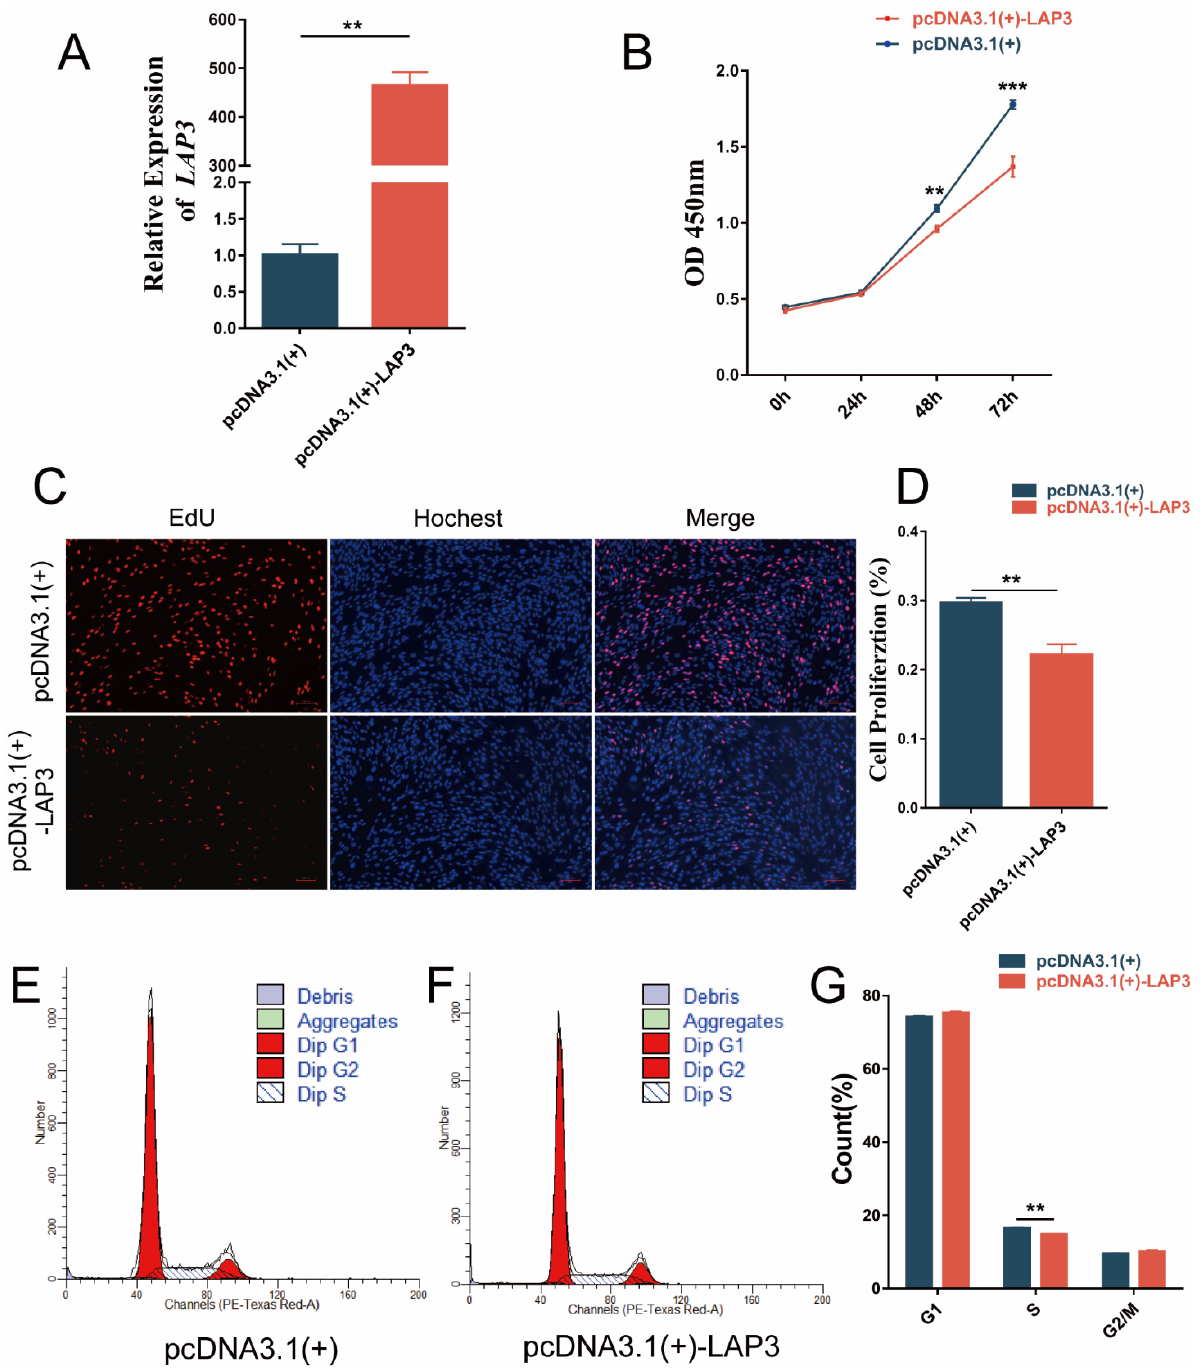
Figure 4. Effects of LAP3 overexpression on embryonic myoblasts proliferation. ( A ) Overexpression efficiency of LAP3 mRNA expression levels detected by RT-PCR in embryonic myoblasts. ( B ) CCK-8 assay of embryonic myoblasts transfected with pcDNA3.1(+)-LAP3 or pcDNA3.1(+) at 0 h, 24 h, 48 h, and 72 h. ( C ) EdU cell proliferation assay of embryonic myoblasts transfected with pcDNA3.1(+)-LAP3 or pcDNA3.1(+) (100×). ( D ) Cell proliferation rate of embryonic myoblasts transfected with pcDNA3.1(+)-LAP3 or pcDNA3.1(+). ( E , F ) Flow cytometric measurement of DNA content using propidium iodide (PI) staining of embryonic myoblasts transfected with pcDNA3.1(+)-LAP3 or pcDNA3.1(+). ( G ) Ratio of embryonic myoblasts at different stages of cell cycle transfected with pcDNA3.1(+)-LAP3 or pcDNA3.1(+). ** p < 0.01, or *** p < 0.001 extremely significant difference according to Student’s t -test; data are shown as mean ± SEM, n = 3 biological